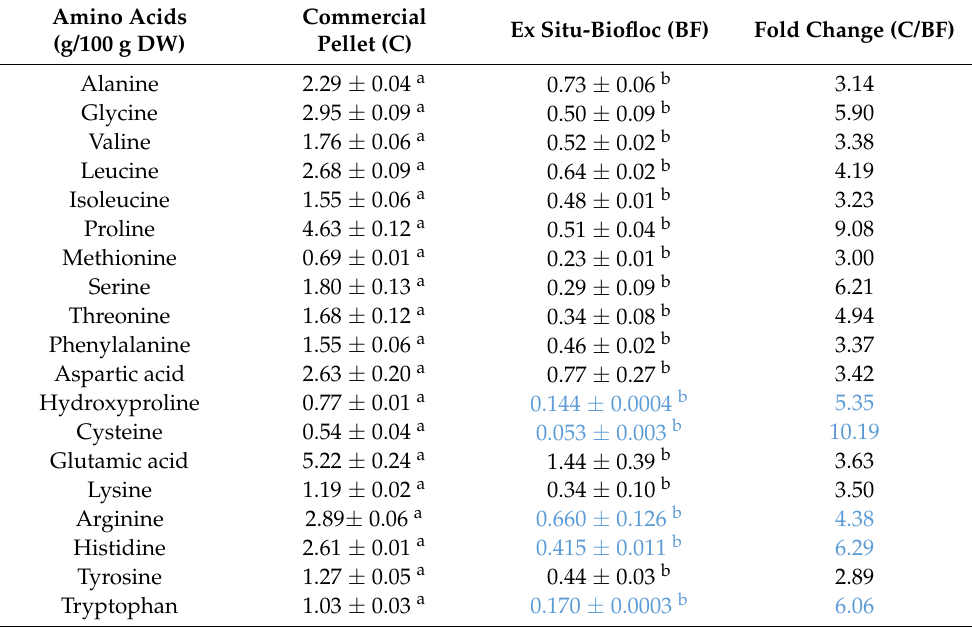
Table 5. Amino acid profiles between commercial pellet and ex-situ biofloc. Different letters above the values indicate significant differences between the feeds. Letters a and b represent statistical analysis using student- t -test. Different letters comparing between commercial pellet and ex-situ biofloc represent significant difference ( p <